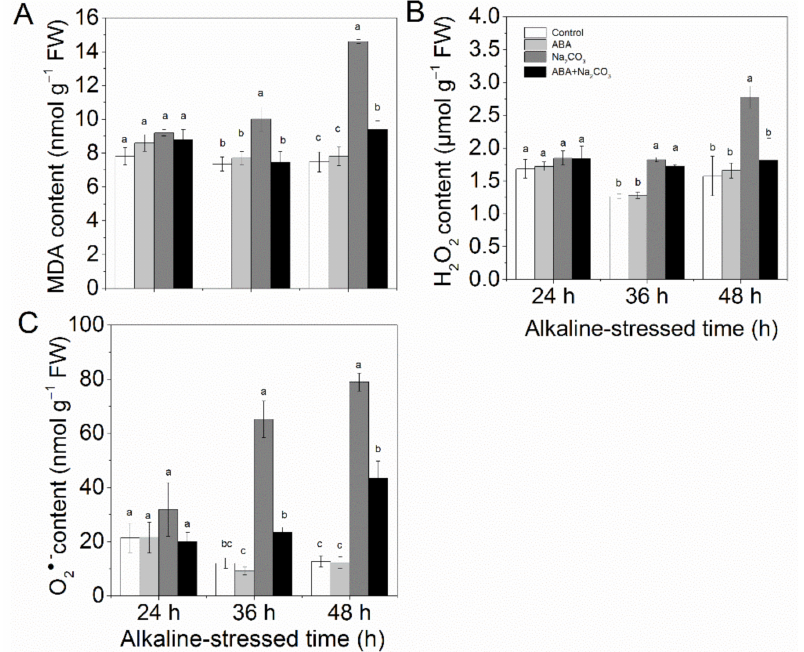
Figure 2. Abscisic acid (ABA) priming decreased MDA content and ROS accumulation in alfalfa ( Medicago sativa L.) seedlings under alkaline stress. Eighteen-day-old alfalfa seedlings were root- drenched with 10 µ M ABA or without ABA (Control) for 16 h and then exposed to unstressed (Control and ABA) or alkaline-stressed (Na 2 CO 3 and ABA + Na 2 CO 3 , 15 mM Na 2 CO 3 ) conditions. Accumulation of ( A ) malonaldehyde (MDA), ( B ) H 2 O 2 , and ( C ) O 2 •− in the leaves was determined after 24 h, 36 h, and 48 h of alkaline treatment. Values are the mean ± standard error, n = 3. Different letters above the columns indicate significant differences ( p < 0.05) at each time point based on Duncan’s test.